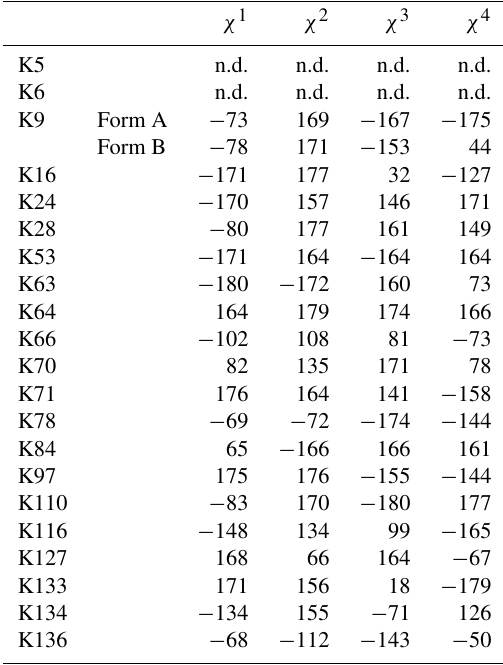
Table A1. List of the dihedral angles ( χ 1 , χ 2 , χ 3 , χ 4 ) in the